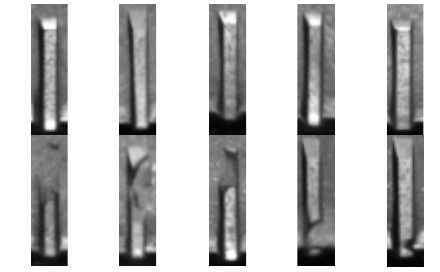
Figure 11. Example of compliant and defective teeth. The defects are sorted from the biggest to the smallest. the smallest.